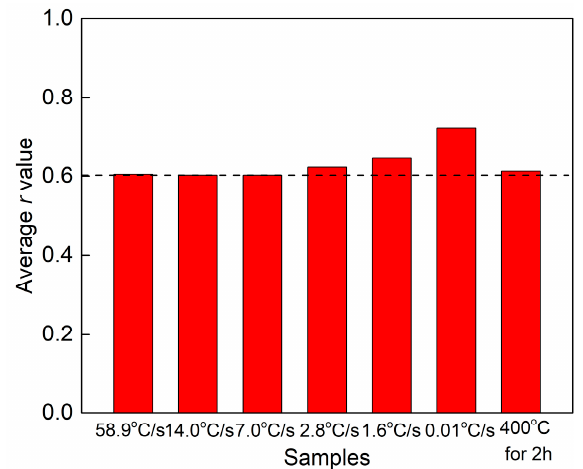
Figure 7. Average r value of samples in the T4P state.